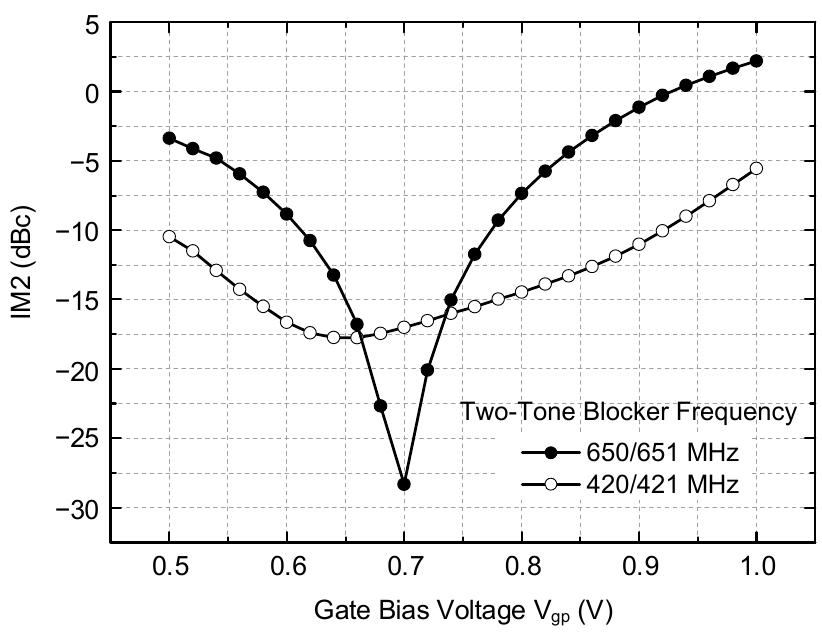
Figure 6. Simulation results of the IM2 calibration.